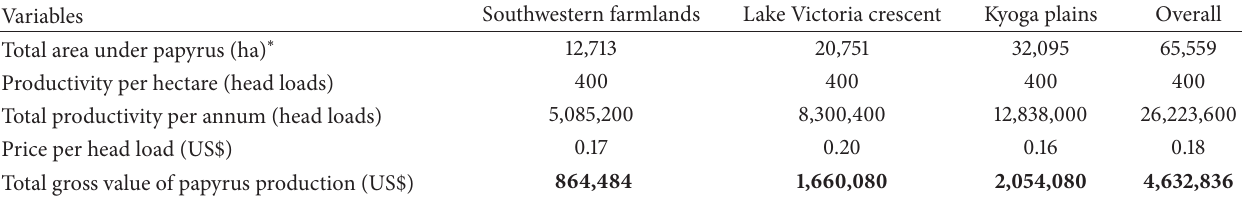
Table 10: Monetary value of papyrus raw materials without value addition in three wetland agro-ecological zones in Uganda.